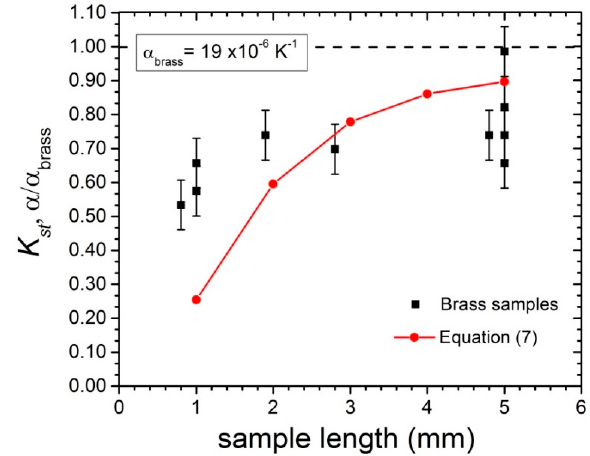
Figure 14. Strain transfer coefficient computed using Equation (7) (red circles), and measured coefficient of thermal expansion divided by α brass = 19 ppm/K (black squares). The analytic solution fails to reproduce the experimental data in the 1 mm-long sample limit.